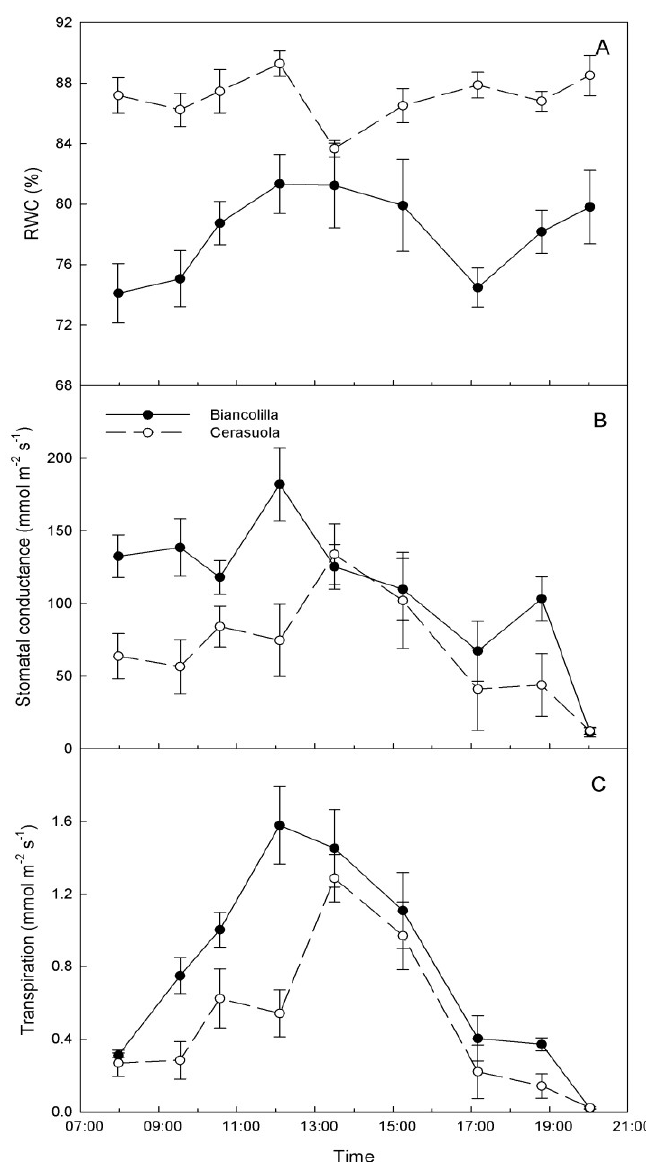
Figure 2. Diurnal changes of ( a ) relative water content (RWC); ( b ) stomatal conductance (g ); and ( c ) transpiration rate (T) in leaves of ‘Biancolilla’ and ‘Cerasuola’ olive trees s during a typical summer day in Sicily. Error bars represent standard errors of